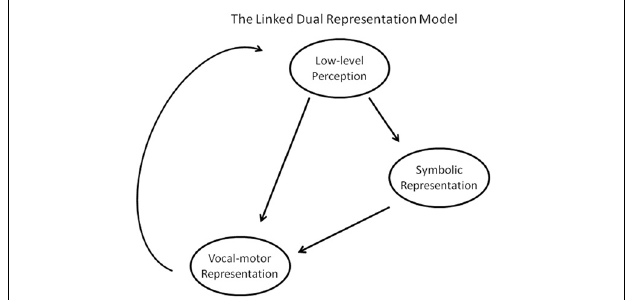
FIGURE 2 | The Linked Dual Representation